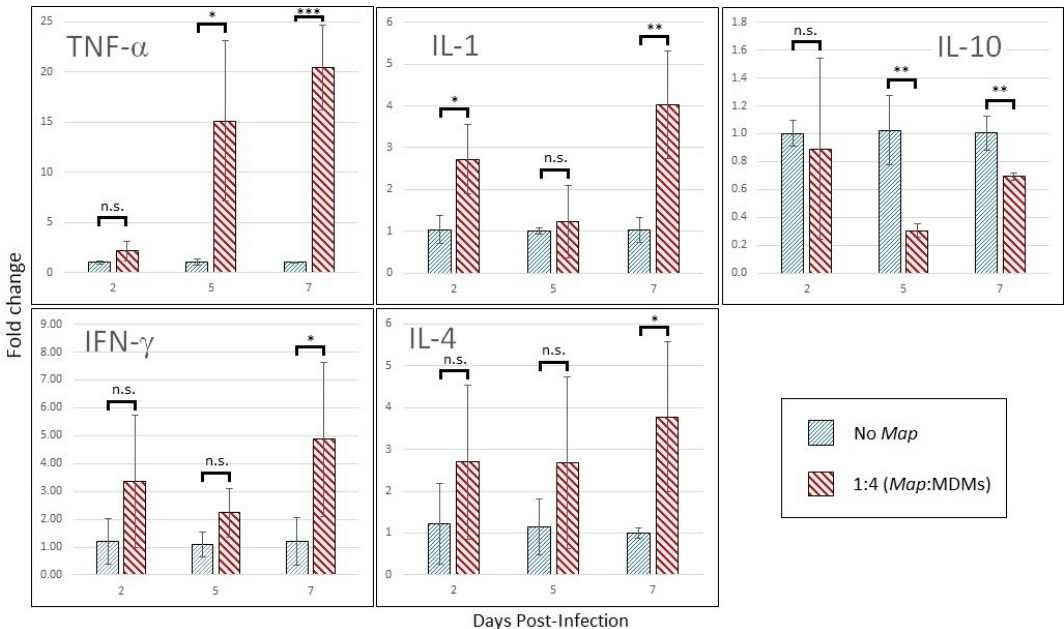
Figure 5. Cytokine profile shift of Map -infect MDMs across the time-course. Cytokine expression of MDMs infected with Map at an MOI of 1:4 compared to same-day uninfected MDMs. RT-qPCR was run using actin as internal control, and the data was converted to fold-change by ∆ - ∆ - C t method. The bars are standard deviation. * p < 0.05; ** p < 0.01; *** p < 0.001; n.s. = not significant by student’s t-test (n = 3).